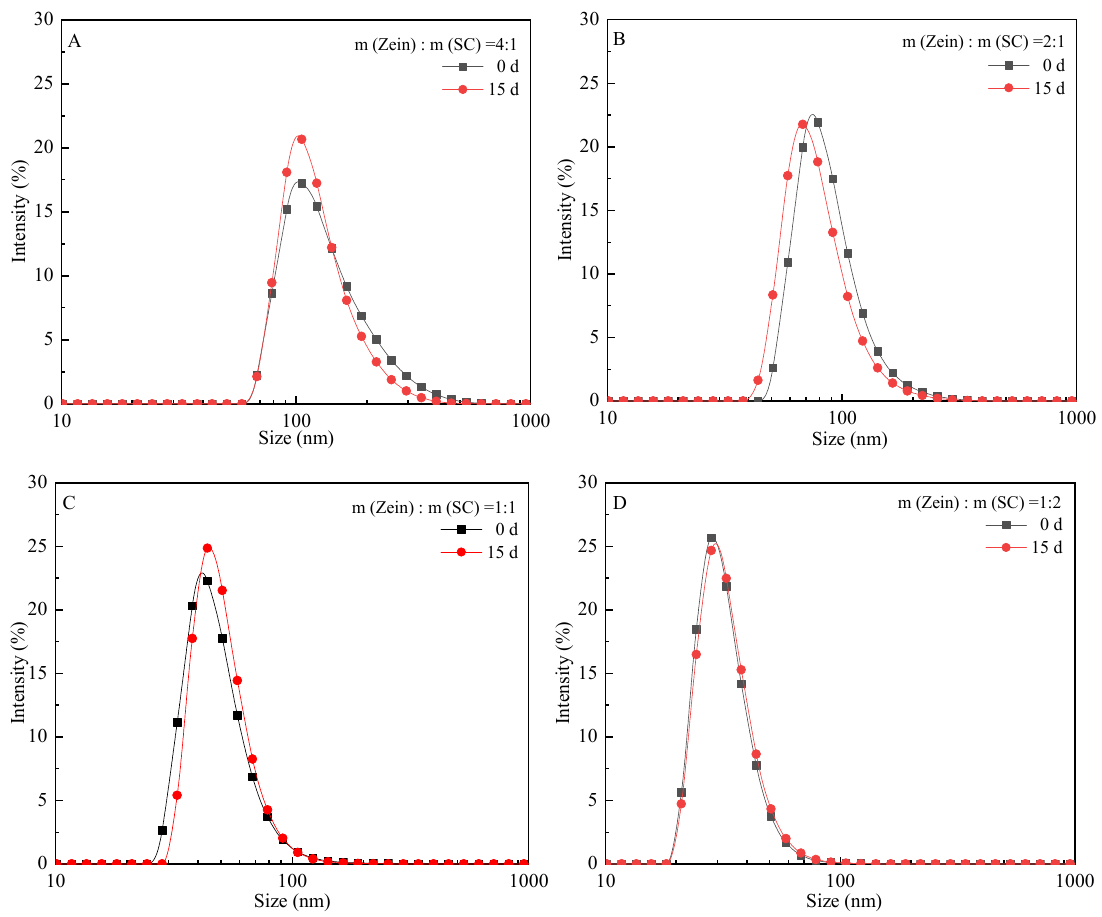
Figure 5. The size of zein/SC/CA composite NPs with different mass ratios, after storage for 0 and 15 days. ( A ) zein/SC mass ratios of 4:1; ( B ) zein/SC mass ratios of 2:1; ( C ) zein/SC mass ratios of 1:1; ( D ) zein/SC mass ratios of 1:2.